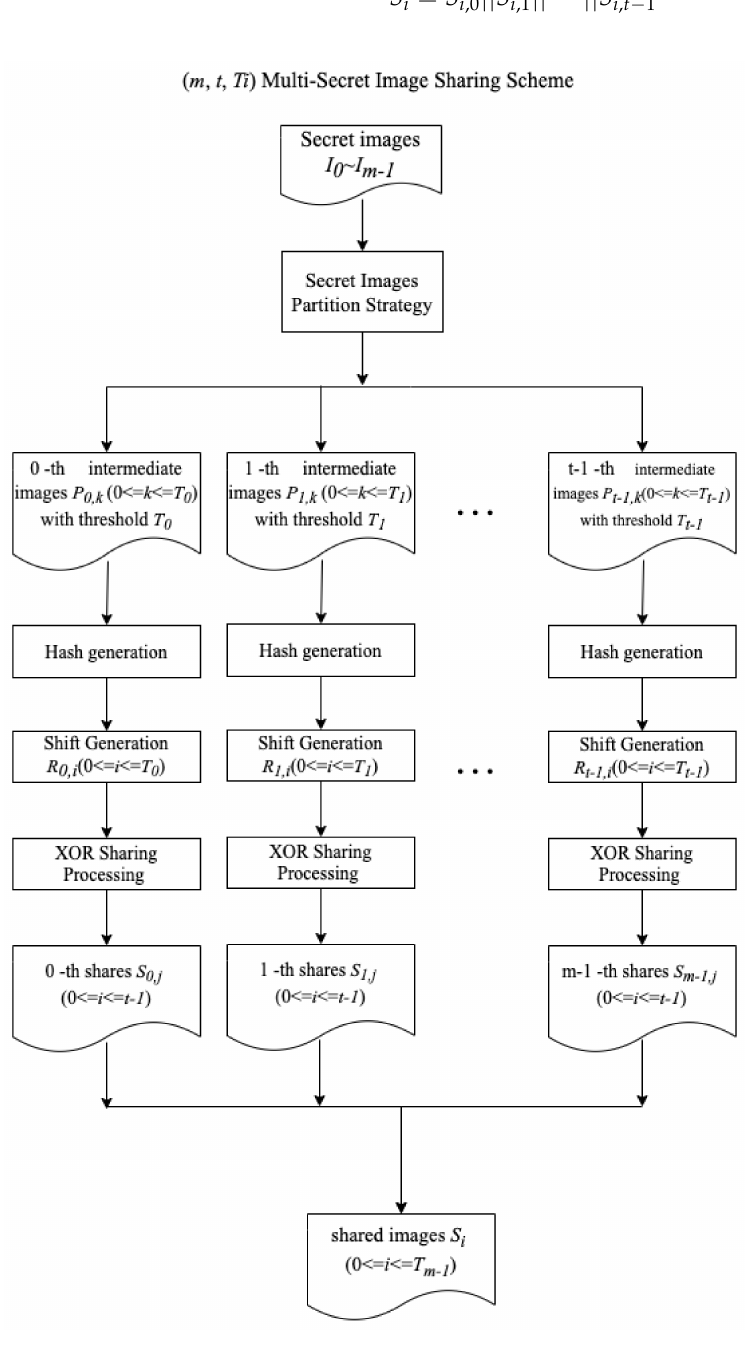
Figure 4. The proposed sharing